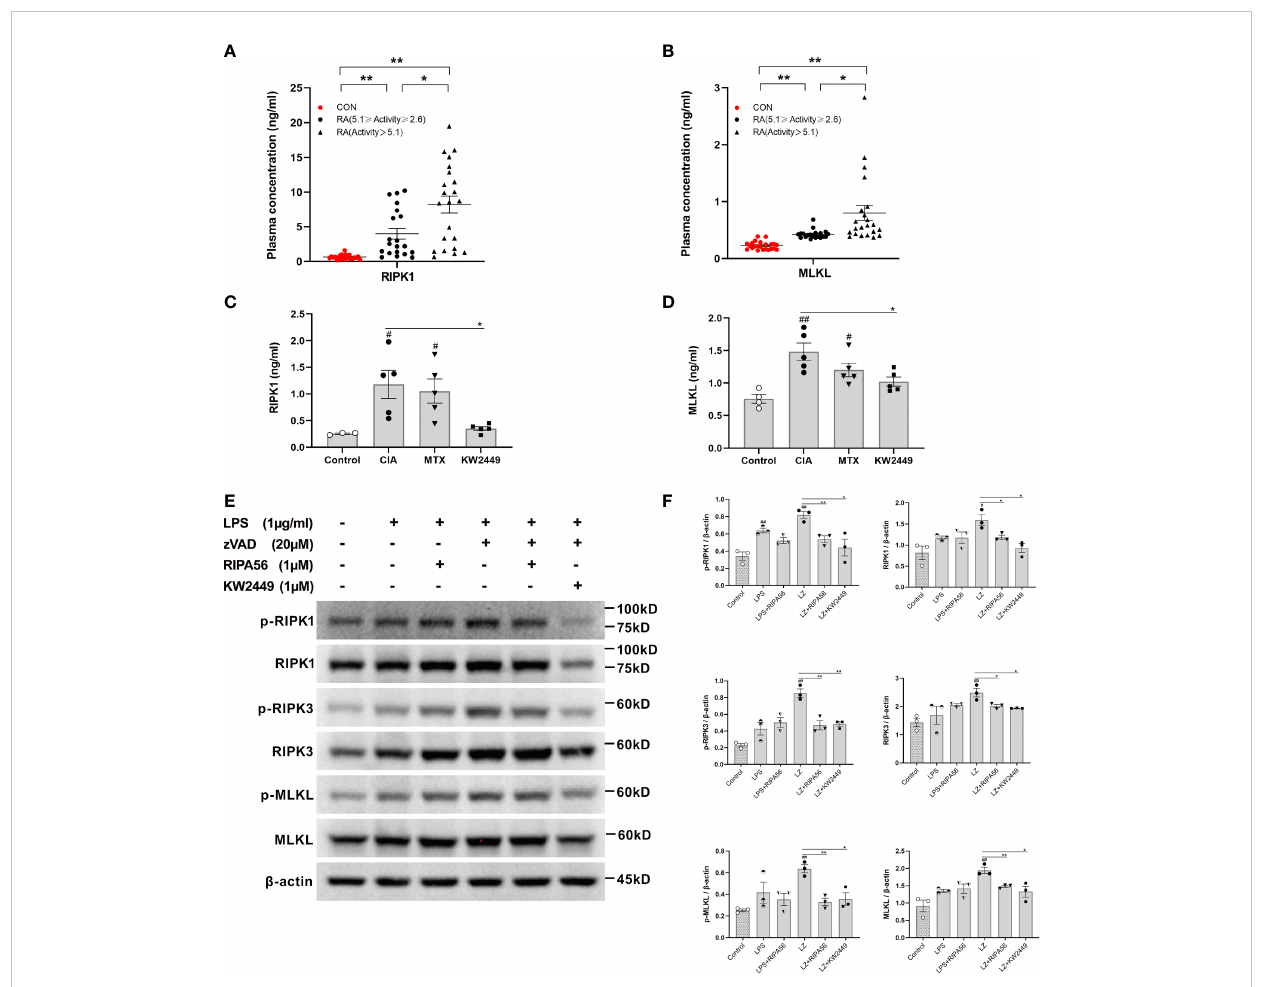
FIGURE 2 The level of RIPK1-mediated necroptosis-related proteins in RA and the effect of KW2449 on RIPK1. (A, B) ELISA analysis of RIPK1 and MLKL protein levels in the plasma of healthy people (n = 23) and RA patients. RA patients were grouped by the Disease Activity Score in 28 joints-Erythrocyte Sedimentation Rate (DAS28-ESR), 5.1 ≥ Activity ≥ 2.6 (n = 20), Activity >5.1 (n = 22). Means ± SEs, * P < 0.05, ** P < 0.01. (C, D ) ELISA analysis of RIPK1 and MLKL protein levels in the plasma of rats in each group. Means ± SEs, n=5, # P < 0.05, ## P < 0.01, vs. Control, * P < 0.05, vs. CIA. (E, F) p-RIPK1, RIPK1, p-RIPK3, RIPK3, p-MLKL and MLKL expression in RAW 264.7 cells was detected by Western blot. Means ± SEs, n=3, # P < 0.05, ## P < 0.01, vs. control, * P < 0.05, ** P < 0.01, vs.